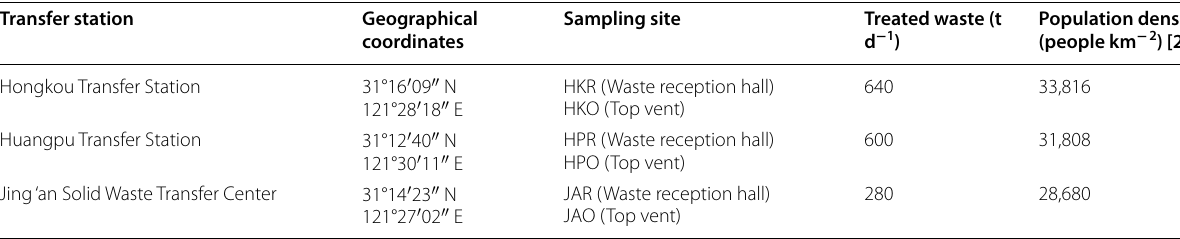
Table 1 Information of MSW transfer